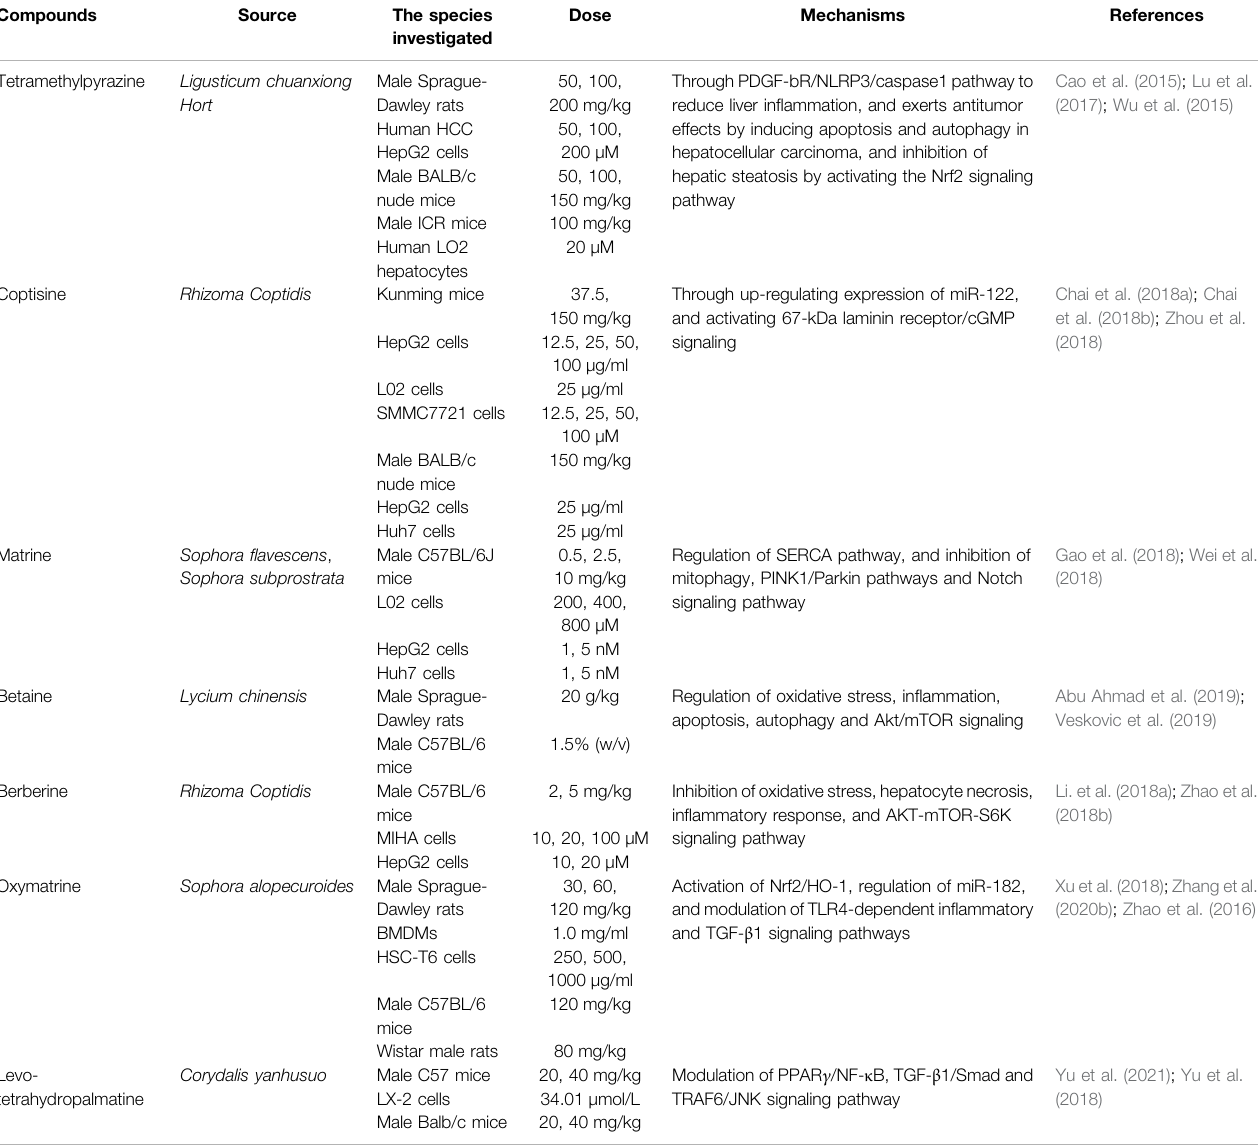
TABLE 5 | Summary of alkaloids with signi fi cant anti-liver disease activity.